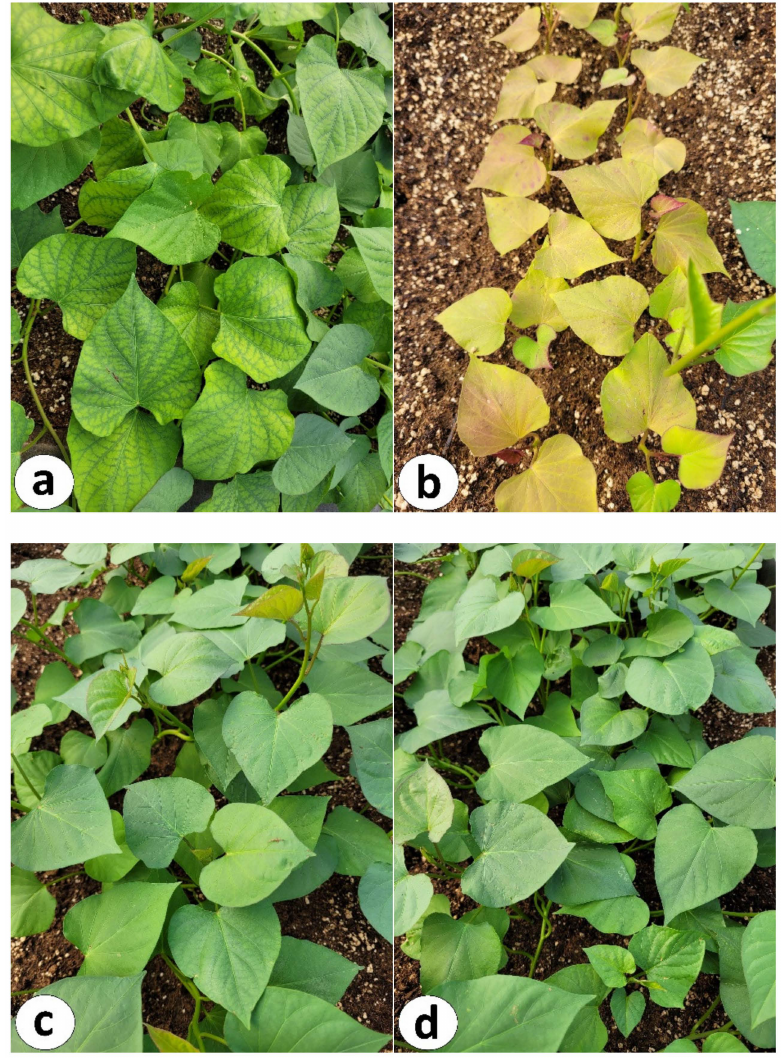
Figure 3. Sweetpotato slips after 3 weeks of being grown with daily applications of an inorganic fertilizer ( a ), daily applications of black solider fly larvae (BSFL) frass tea ( b ), one time top dressing of BSFL frass at 333.7g/m 2 ( c ) or one time top dressing of BSFL frass at 667.4g/m 2 ( d ). The leaves in the BSFL frass treatments appeared greener with no chlorosis that may influence willingness to